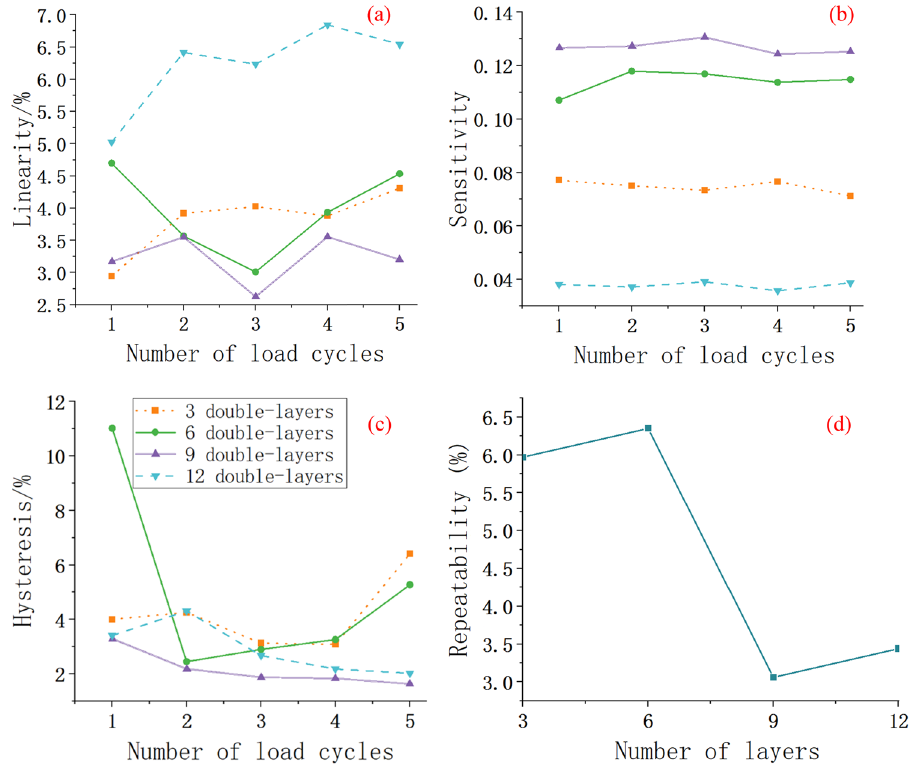
Figure 8: E ff ect of the number of layers of CNTFS assembly on sensing performance: ( a ) linearity, ( b ) sensitivity, ( c ) hysteresis, and ( d )